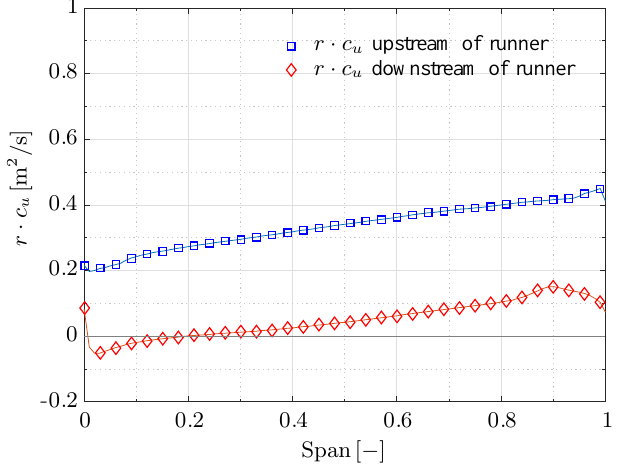
Fig. 10. Distribution of r · c u upstream and downstream of the runner in turbine